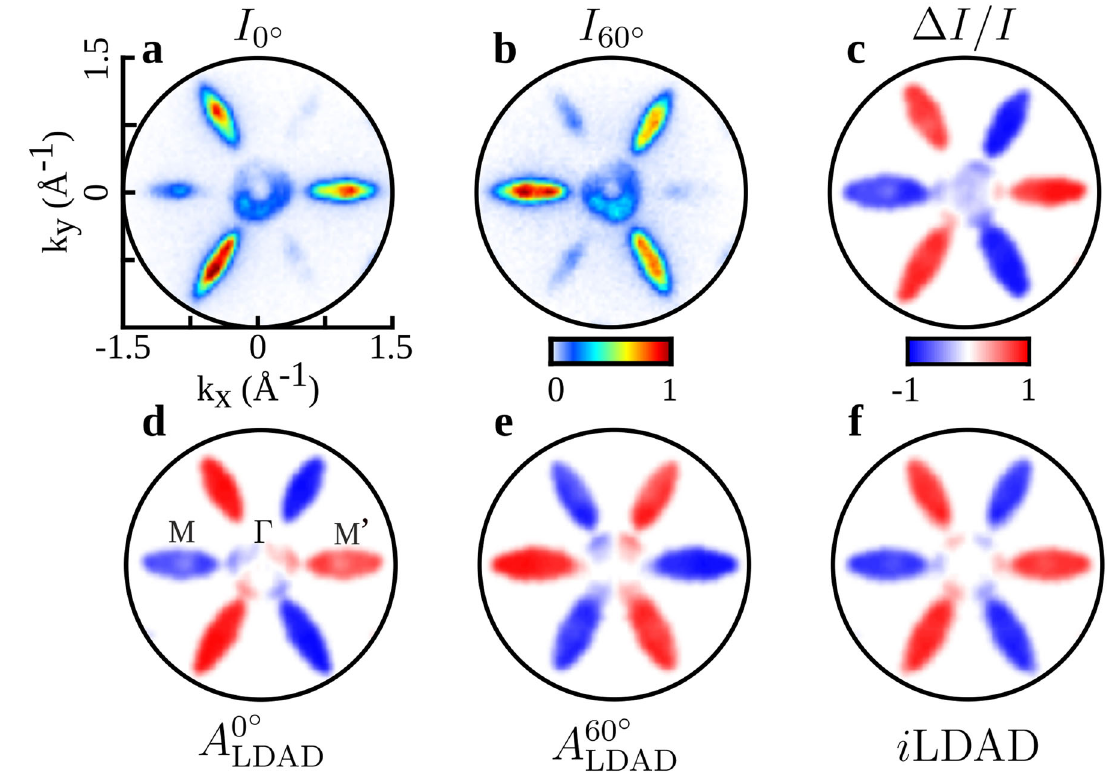
Fig. 2 Extraction of the intrisic linear dichroism in photoelectron angular distributions ( i LDAD). a and b I 0 (cid:2) and I 60 (cid:2) , the CECs at the Fermi energy, measured for two crystal orientations rotated by 60° with respect to each others. c Δ I / I , the raw normalized difference, i.e . ( I 0 (cid:2) − I 60 (cid:2) )/ and A 60 (cid:2) , the “ left – right asymmetries'', re fl ect the photoemission intensity ( I 0 (cid:2) + I 60 (cid:2) ) between CECs shown in ( a ) and ( b ). d and e A 0 (cid:2) LDAD LDAD asymmetry between the k x < 0 and k x > 0 hemispheres, for two crystal orientations, respectively. f i LDAD represents the component of A 0 (cid:2) = 60 (cid:2) LDAD which is antisymmetric upon 60 ∘ azimuthal rotation of the calculated DFT band structure along the M – Γ – M ′ cut are shown in Fig. 3. The experimental measured photoemission intensity are shown in Fig. 3a, from which one can clearly recognize the well-